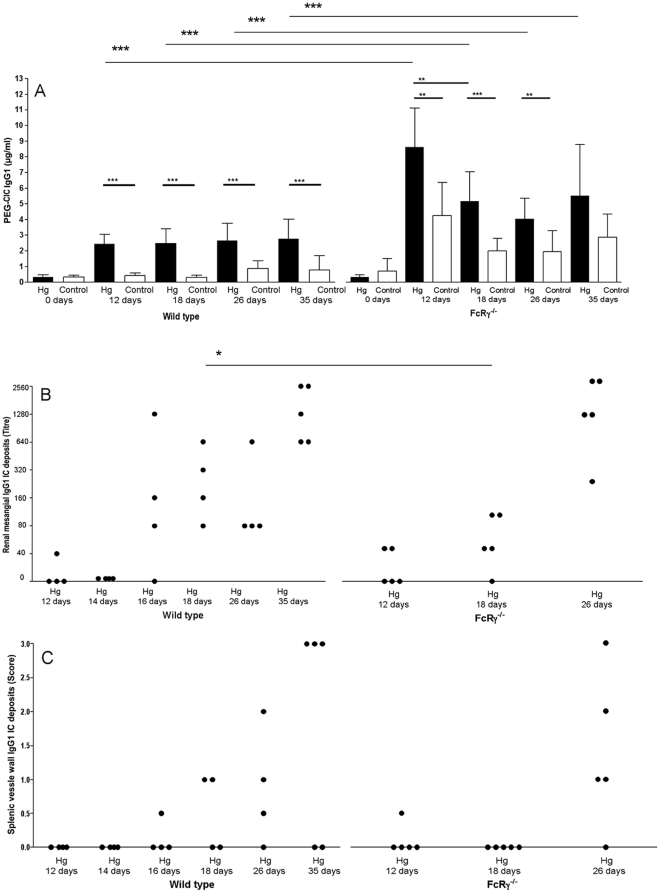
Development of circulating IgG1 immune complexes and tissue IgG1 immune complex deposits.Development of circulating IgG1-containing immune complexes and tissue IgG1 immune complex deposits during 26–35 days of treatment of female BALB/c wild type and FcRγ−/− mice with 15 mg/L HgCl2 in the drinking water or drinking water without any addition of Hg (controls). (A) PEG-precipitated circulating immune complexes containing IgG1 antibodies. The bars denote mean ± SD. ** p<0.01 and *** p<0.001 (Mann-Whitney's test). (B) Renal mesangial IgG1 and (C) splenic vessel wall IgG1 deposits. Each symbol represents a single mouse. * p<0.05 (Mann-Whitney's test).